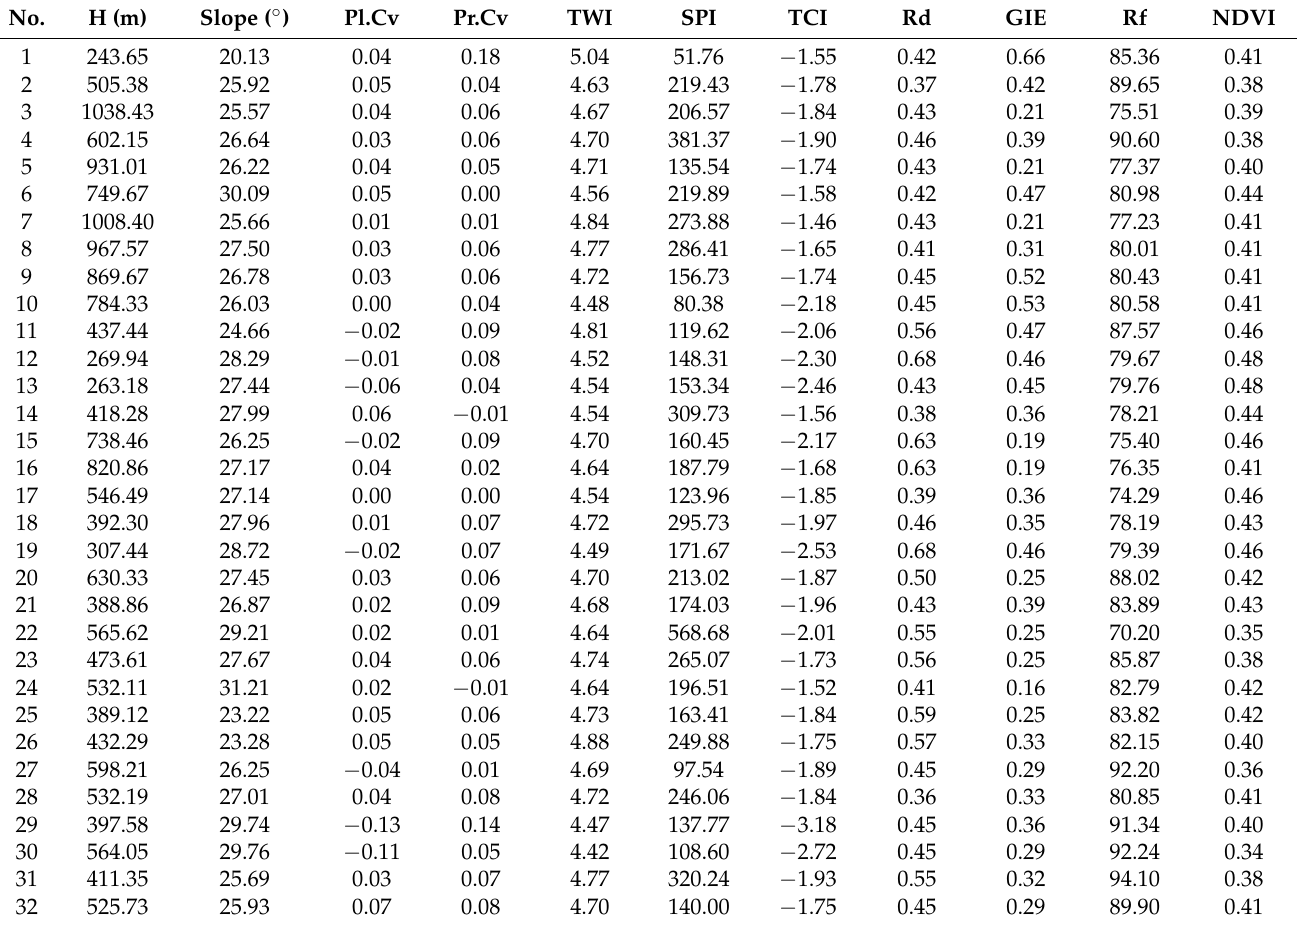
Table A1. The basic statistics of 43 debris flow